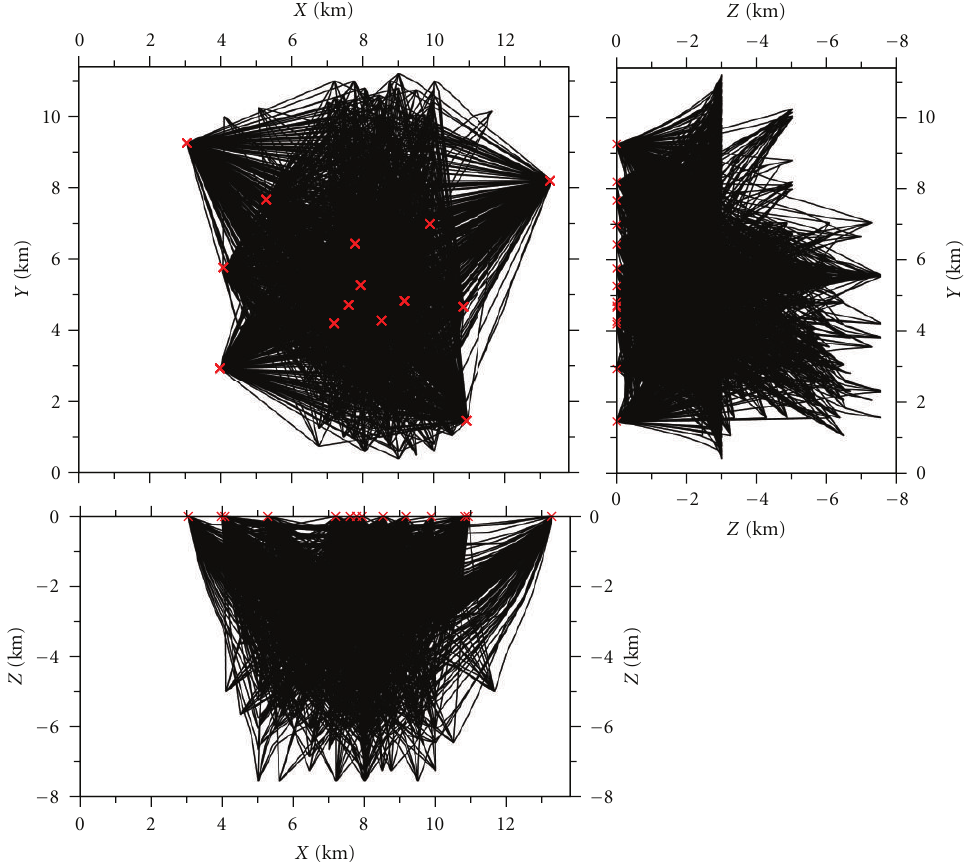
Figure 10: Ray coverage projection along three orthogonal sections for the true